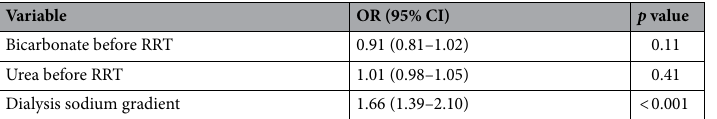
Table 6. Variables associated with the natraemia change by multivariate analysis. Hosmer–Lemeshow: 0.95; AUC-ROC: 0.94.